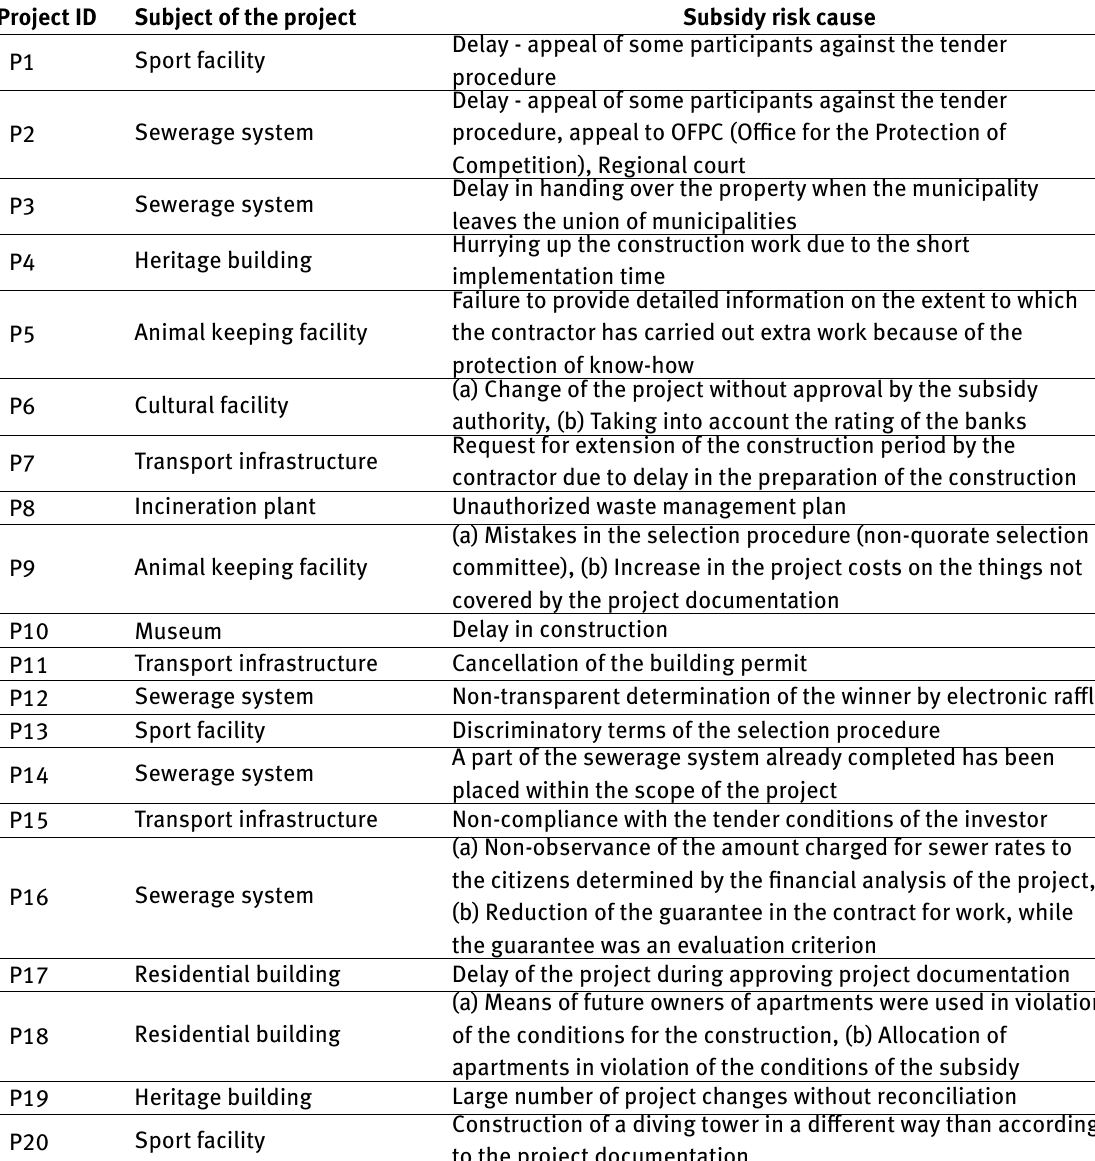
Table 1: Overview of projects and identified risk causes Project